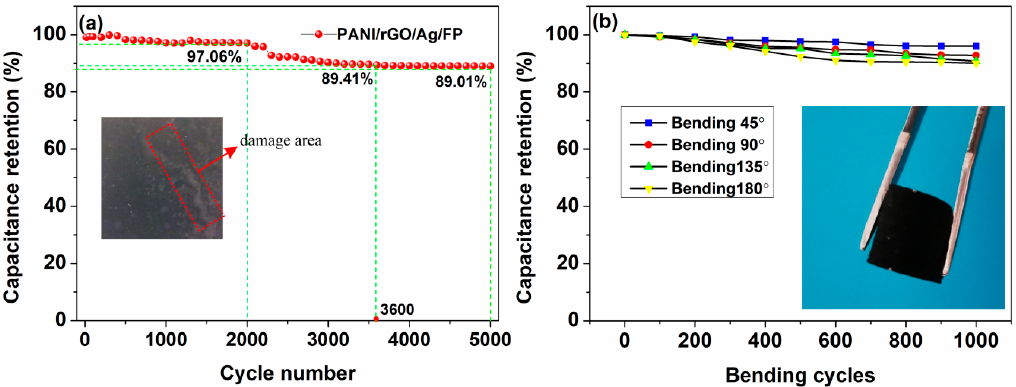
Figure 6. ( a ) The specific capacitance retention rate of the PANI / rGO / Ag / FP electrode over 5000 cycles. ( b ) The specific capacitance retention rate of the PANI / rGO / Ag / FP electrode under different bending degrees.